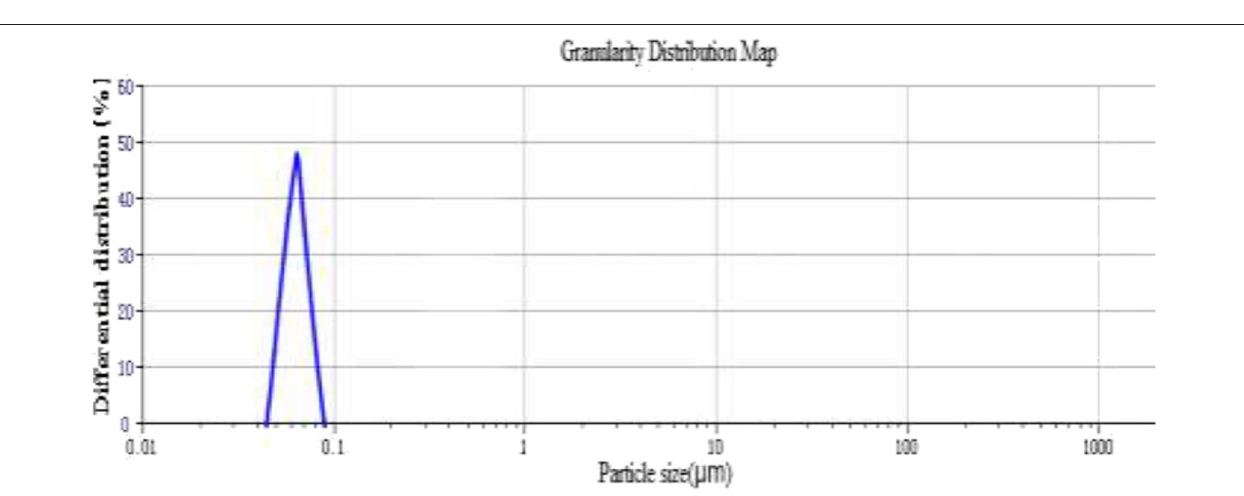
FIGURE 5 | Size distribution of Janus